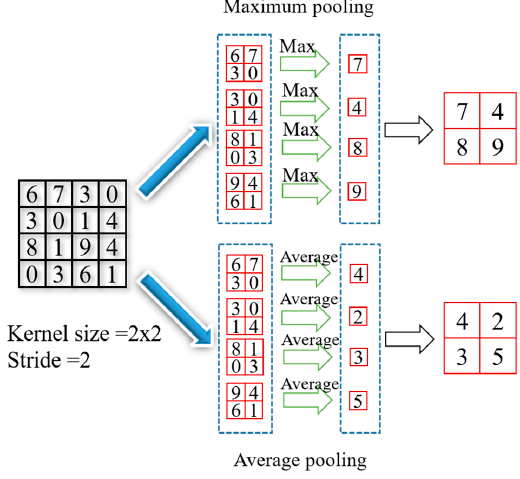
Figure 4. The principle of pooling operation.